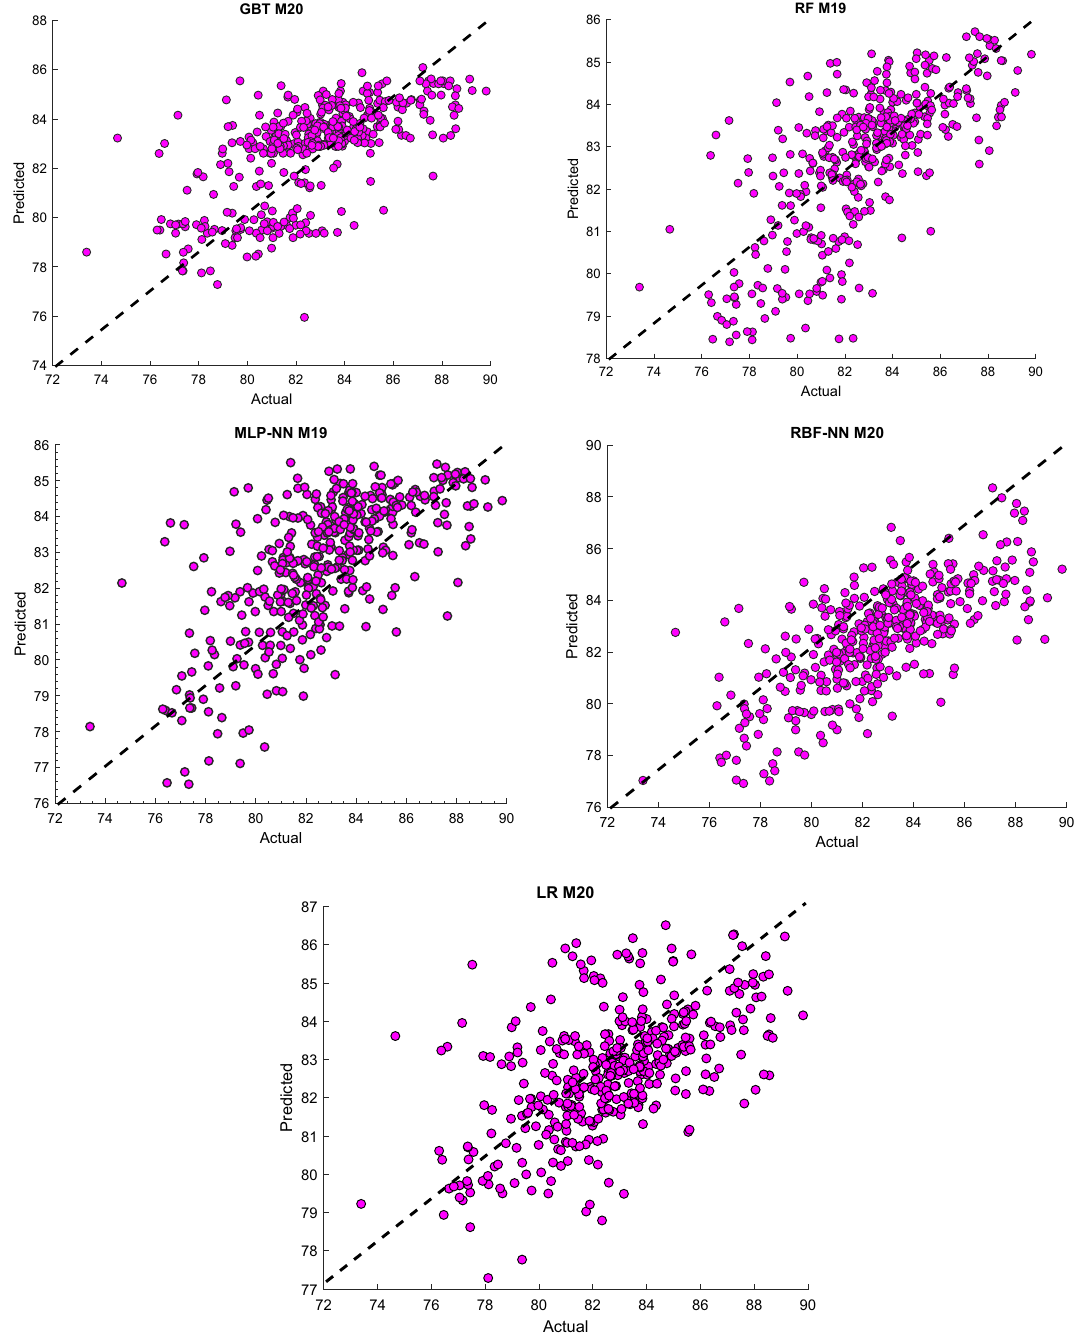
Figure 7. Scatter plots of actual and predicting monthly Rh use the most accurate combination of input parameters using the developed ML